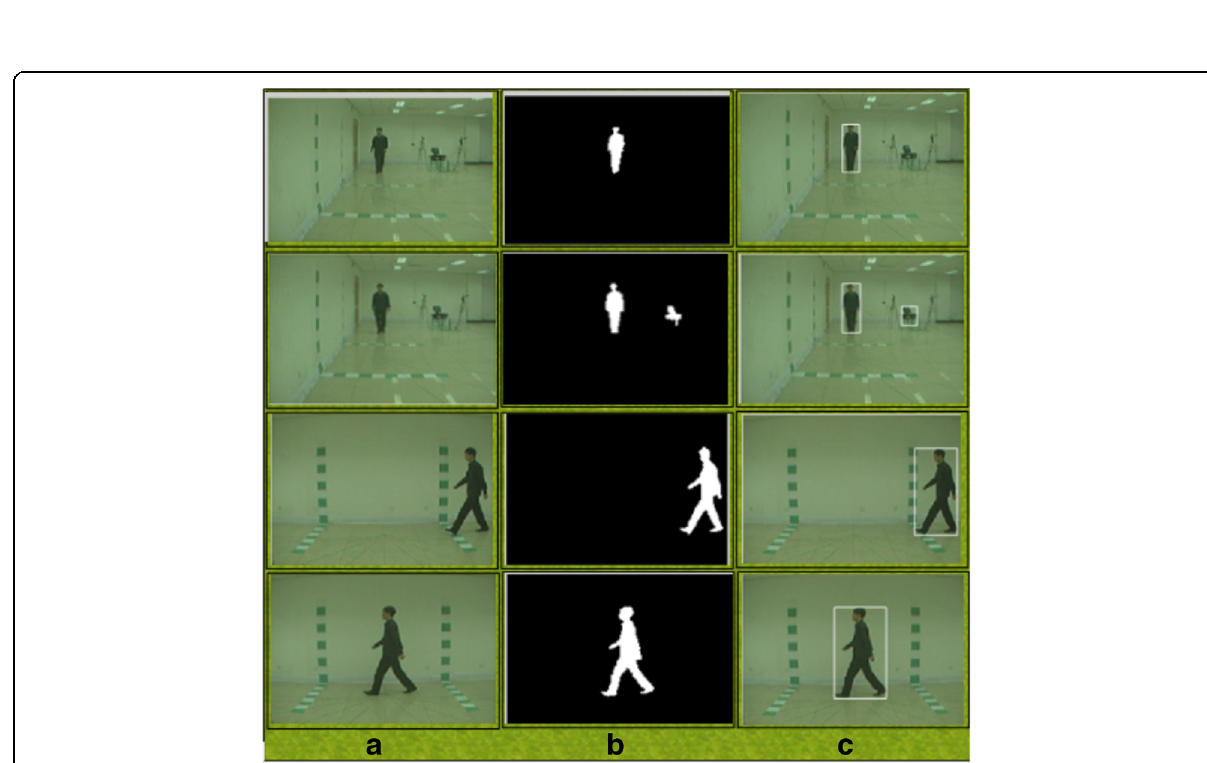
Fig. 7 Segmentation results using CASIA dataset